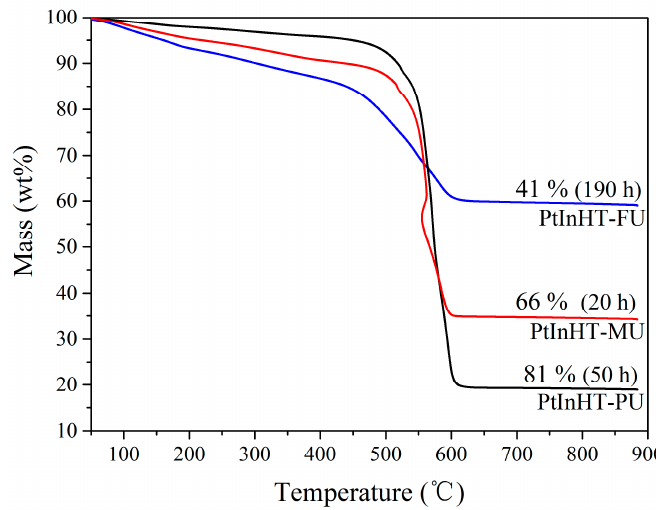
Figure 9. TG profiles of used catalysts with different reaction times.